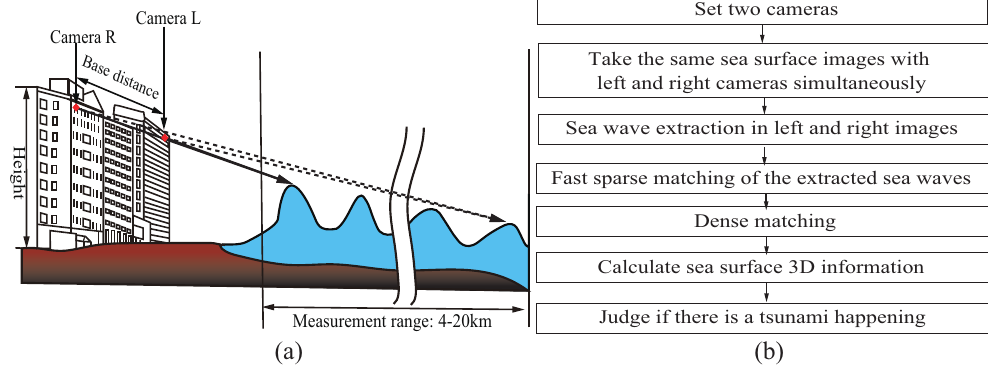
Figure 1. Proposed tsunami measurement system: ( a ) system configuration and ( b ) data processing flow